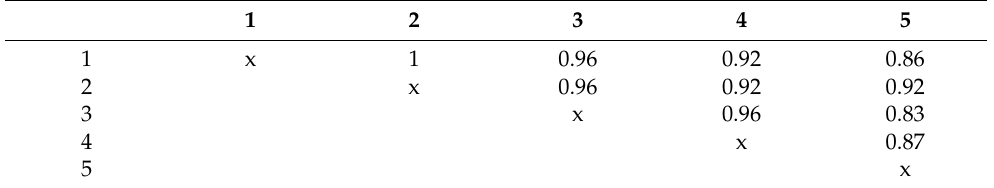
Table 5. The species similarity index between sites in